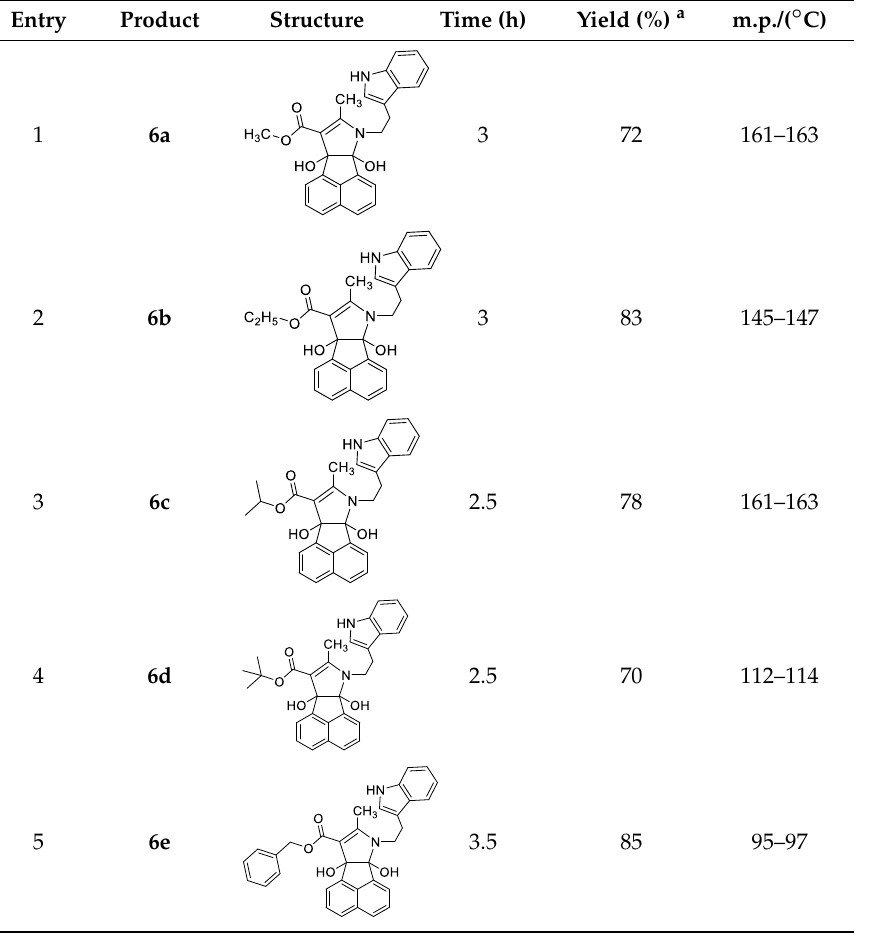
Table 3. The synthesis of compound 6 .